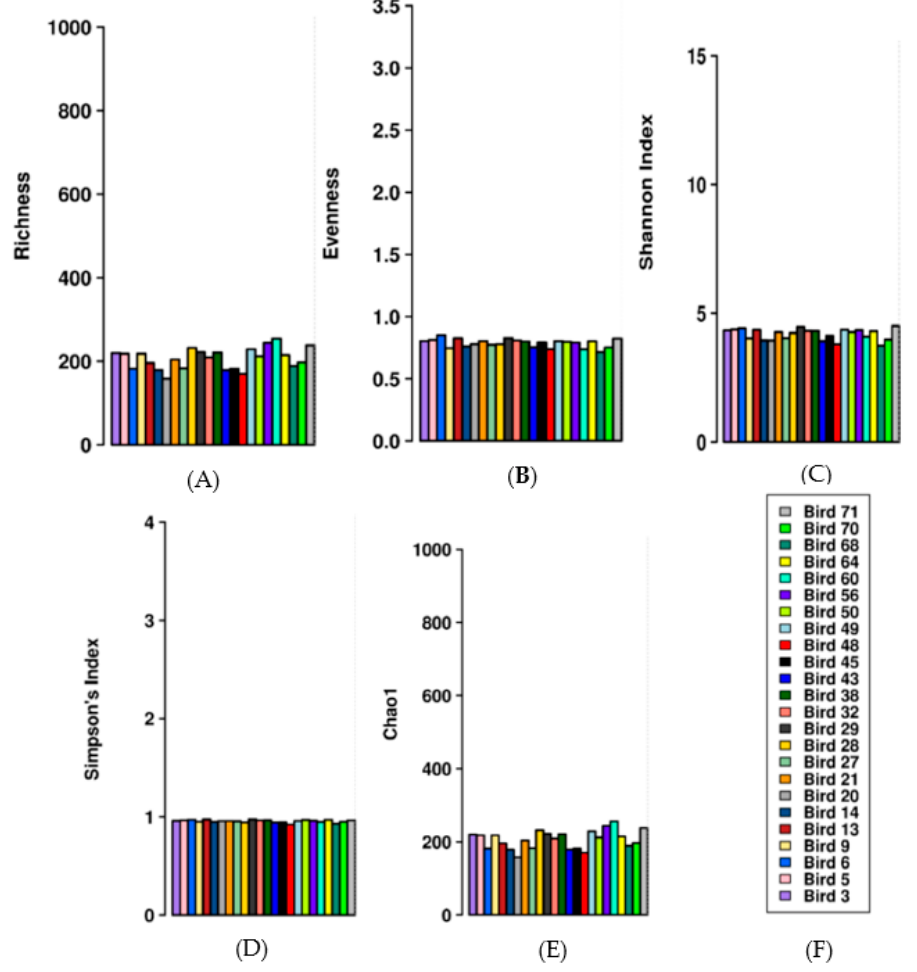
Figure 2. Alpha diversity parameters of caecum microbial profile: richness ( A ), evenness Figure 2. The rank tests for richness, evenness, and the Shannon index. ( B ), Shannon index ( C ), Simpson’s index ( D ), and Chao1 index ( E ) in 24 sampled birds ( F